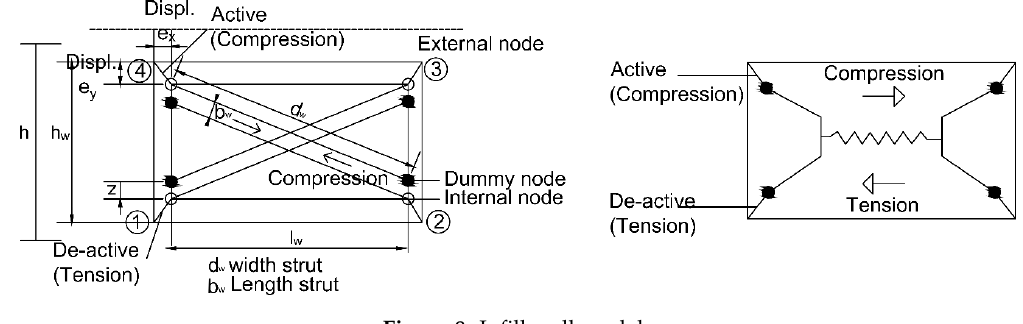
Figure 8. Infill wall model.